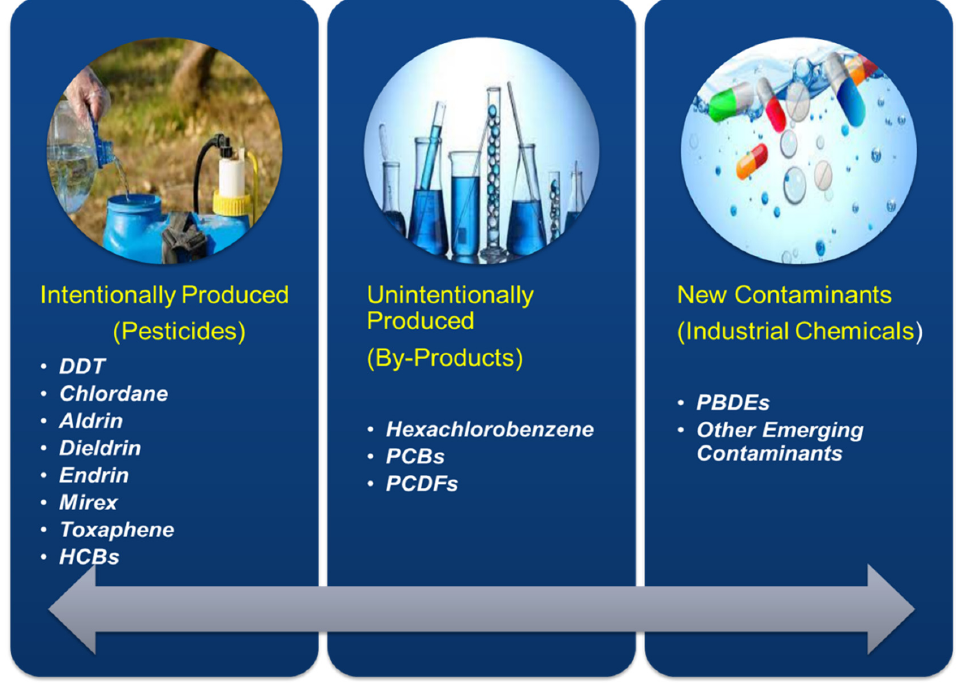
Figure 1. Type and categories of POPs.